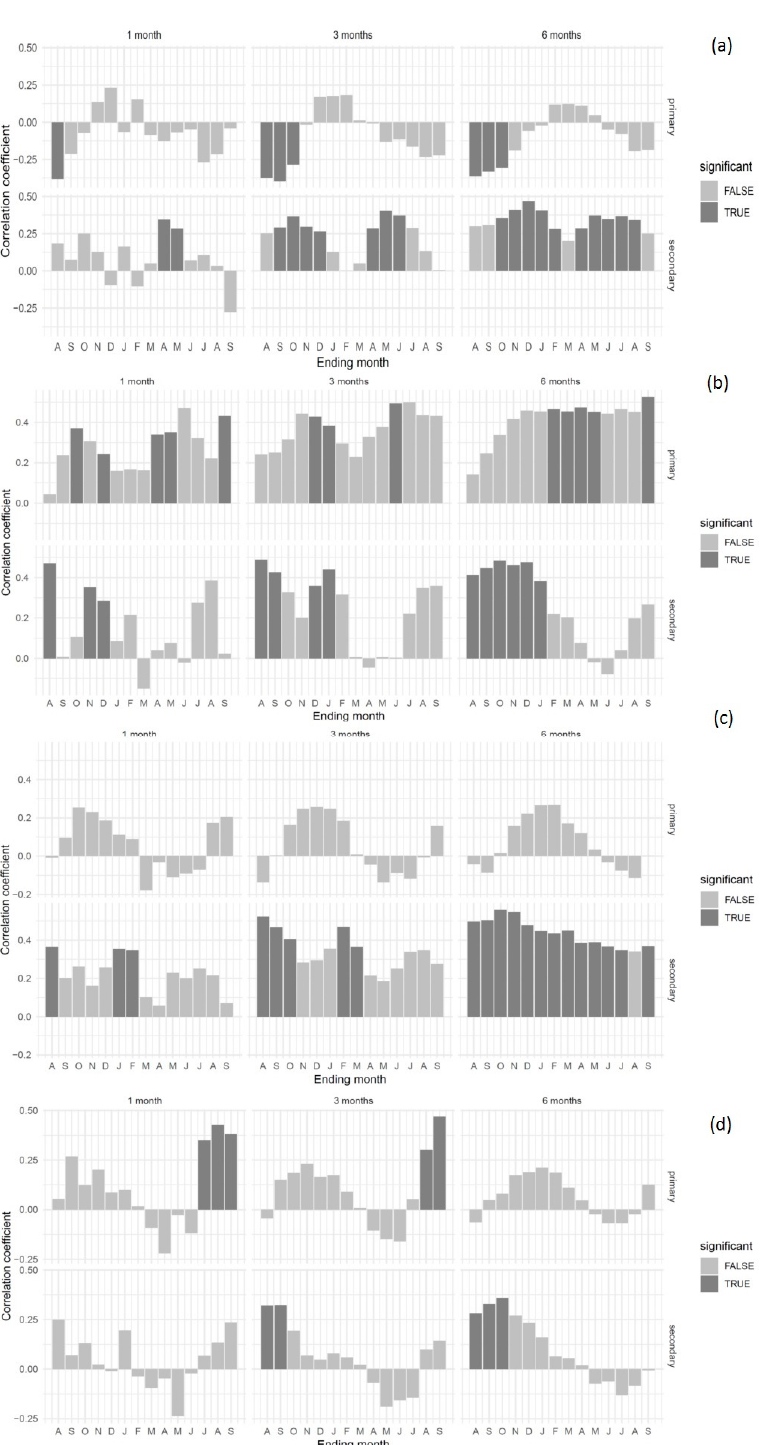
Figure 7. Plot of a seascorr analysis relating ( a ) TRW chronology of Ili; ( b ) δ 13 C series of Ili; ( c ) TRW chronology of Manas; ( d ) δ 13 C series of Manas to temperature and precipitation. Composites with lengths of 1, 3, and 6 months. Simple correlations with monthly temperature (top) and partial correlations with monthly precipitation (bottom). Solid dark bars show significant correlation at p < 0.05 level.